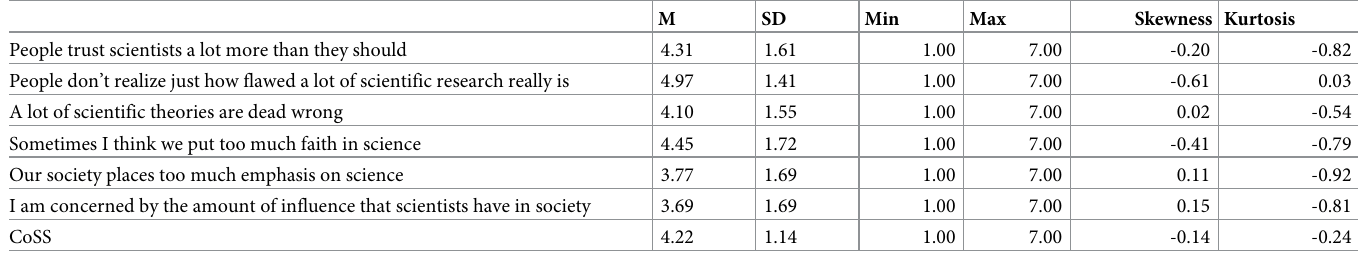
Table 1. Descriptive statistics of the items on the CoSS–Study